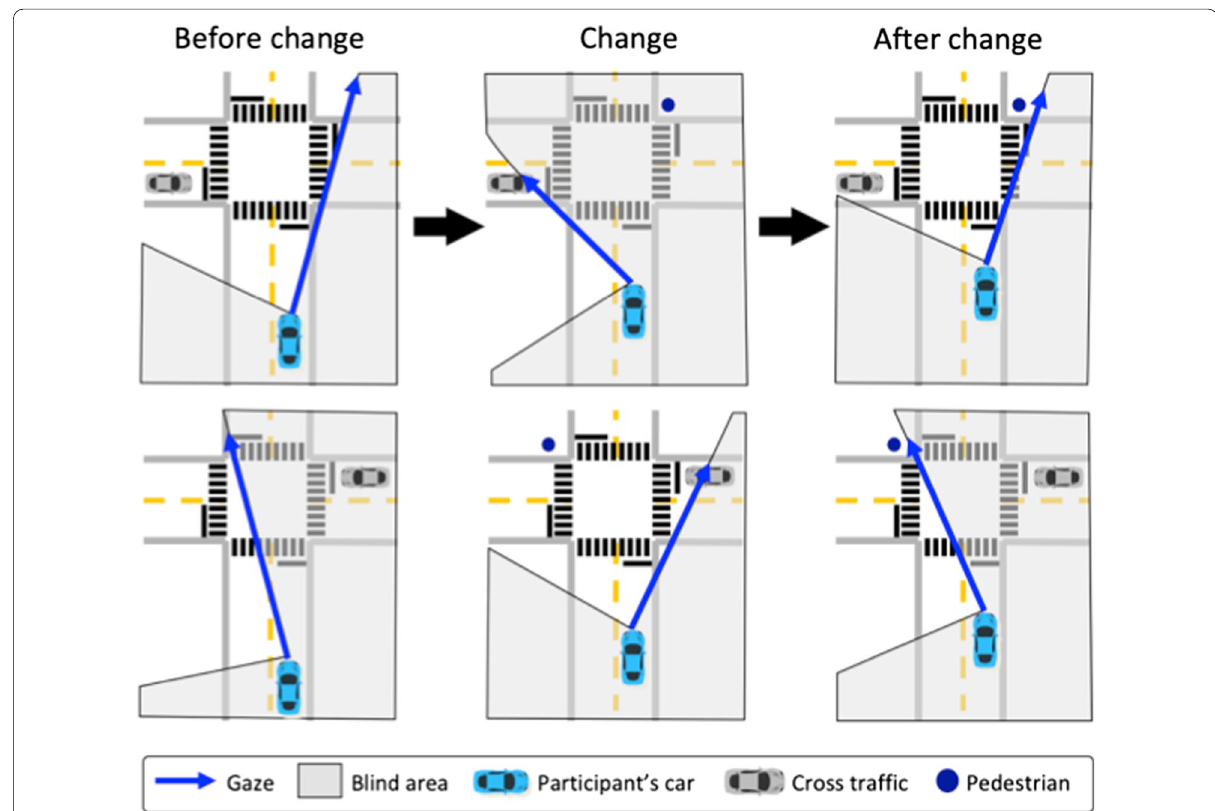
Fig. 3 Illustrations of the gaze-triggered critical pedestrians in condition A in a participant with right HVFL. In the top middle panel, the pedestrian appears in the blind hemifield, and in the bottom middle panel, the pedestrian appears in the seeing hemifield. In both examples, the location of the change was visible before the change in the panels on the left. Then, in the next panels (middle), the participant fixates on the cross-traffic, which triggers the sudden appearance of the pedestrian. In the panels on the right, the participant looks back and the pedestrian is visible in the seeing hemifield. A failed detection of the change would be categorized as change